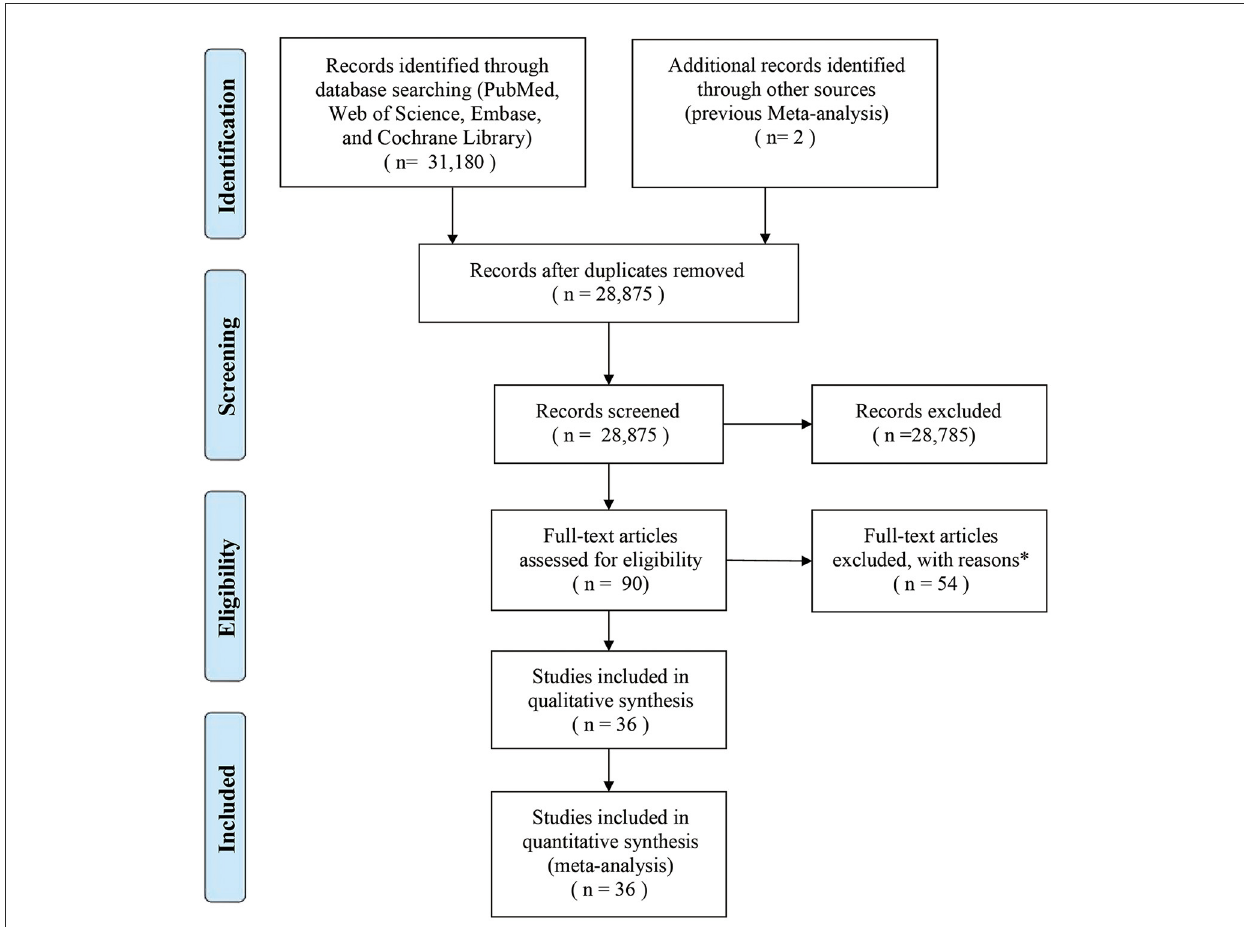
FIGURE1 Flow diagram of the search strategy and identification of studies used in the meta-analysis. *Reasons for the exclusion of 54 studies were as follows: 38 studies lacked sufficient data, 15 studies had small sample sizes, and one study was not published in